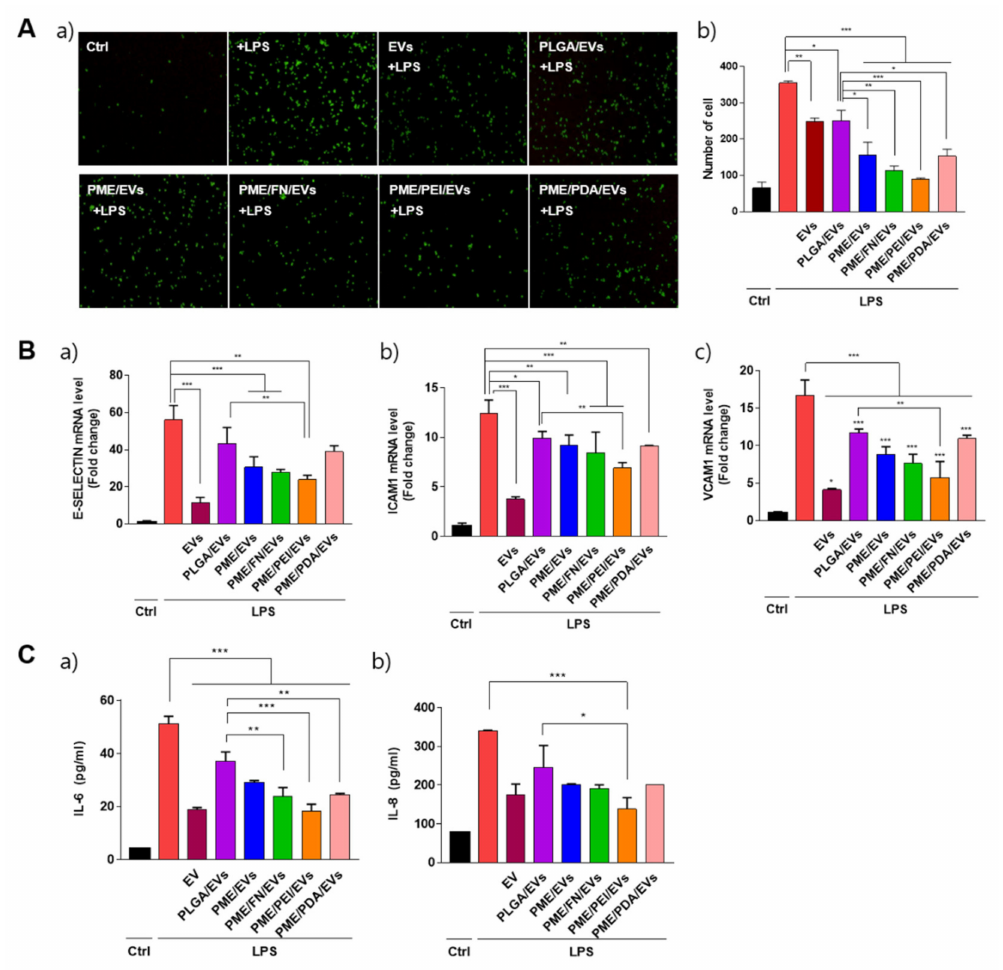
Figure 5. Effect of EVs released from the composite films on inflammation. ( A ) ( a ) Representative images, and ( b ) quantification of THP-1 cells adherent to LPS-activated HCAECs. ( B ) Gene expression levels of cell adhesion molecules. ( a ) E-SELECTIN, ( b ) ICAM1, and ( c ) VCAM1 mRNA expression levels. ( C ) Quantification of secreted pro-inflammatory cytokines. ( a ) IL-6, and ( b ) IL-8 concentrations in cultured medium. The data are expressed as mean ± SD ( n = 3). * p < 0.05; ** p < 0.01; *** p <